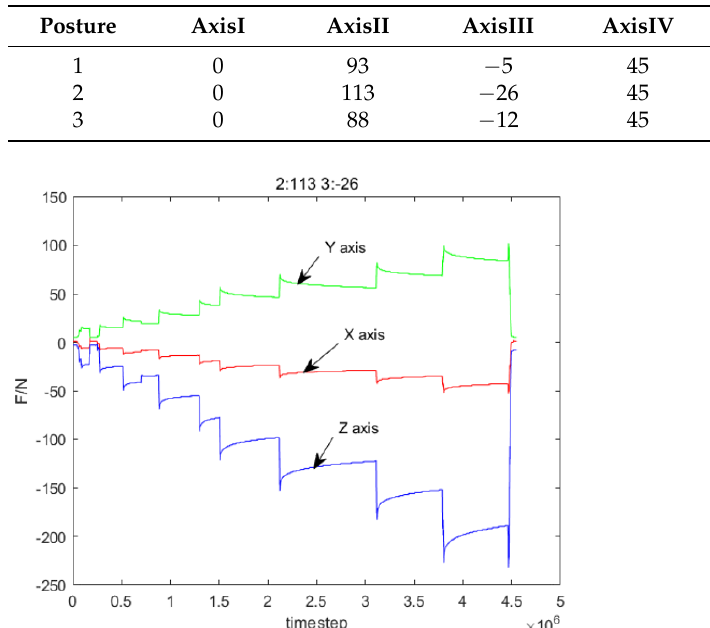
Table A1. Three postures for loading tests in stiffness identification (unit: deg).